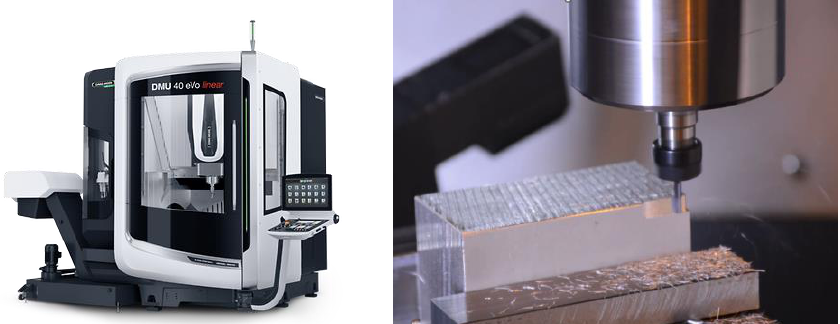
Figure 10. System successfully operating in an industrial tool DMU 40 eVo linear.